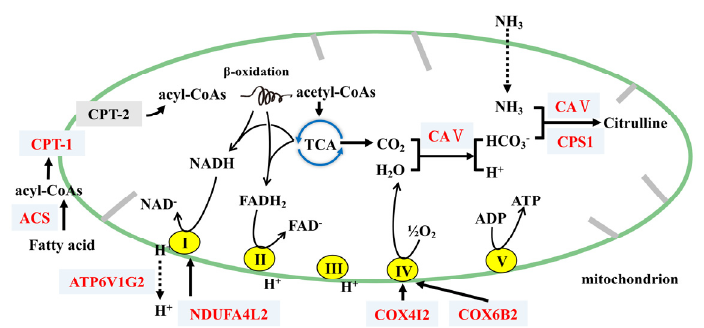
Figure 7. Potential regulatory mechanism by which FP may alter genes related to mitochondrial energy metabolism in CETs. FP upregulated ACS and CPT-1, promoting the conversion of FA to acyl-CoA and the transfer into mitochondria for β -oxidation and the TCA cycle where CO 2 , NADH and FADH2 are produced. Related proteins of complexes I and IV are upregulated, promoting oxidative phosphorylation and generated H 2 O. CA V catalyzes H 2 O and CO 2 into HCO 3 − , and then co-catalyzes for the conversion of NH 3 and HCO 3 − to Citrulline with CPS1. Note that proteins in red represent upregulation in group FPD compared with group HFD, while those in black indicate no significant changes.